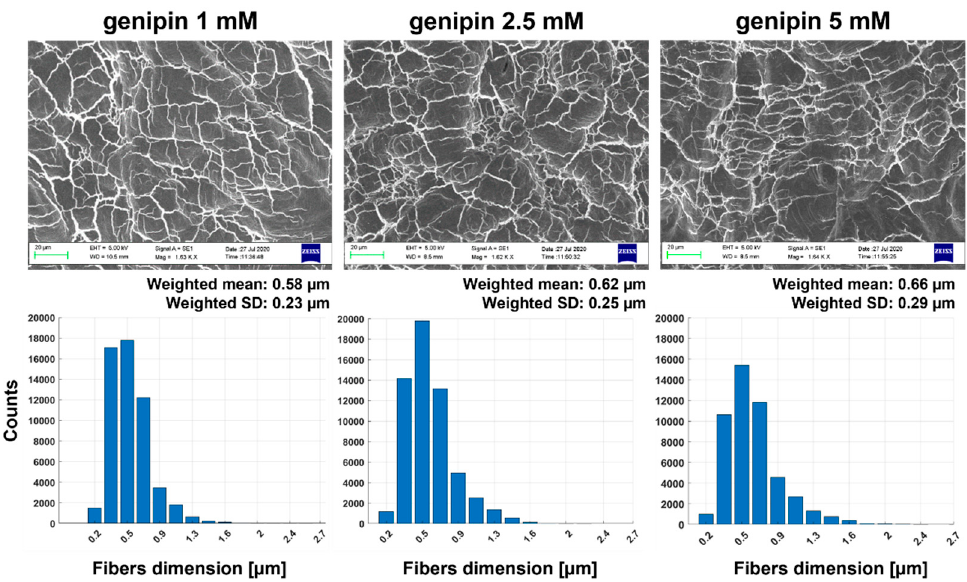
Figure 4. SEM images of JellaGel ™ hydrogels crosslinked with genipin at different concentrations. The images are reported at a magnification of 1600×. They show the internal gel microarchitecture with the domains created by the collagen network. For each concentration, a histogram showing the diameter of the collagen fibers is also reported, highlighting the weighted mean and standard deviation for each concentration. Scale bars = 20 µm.